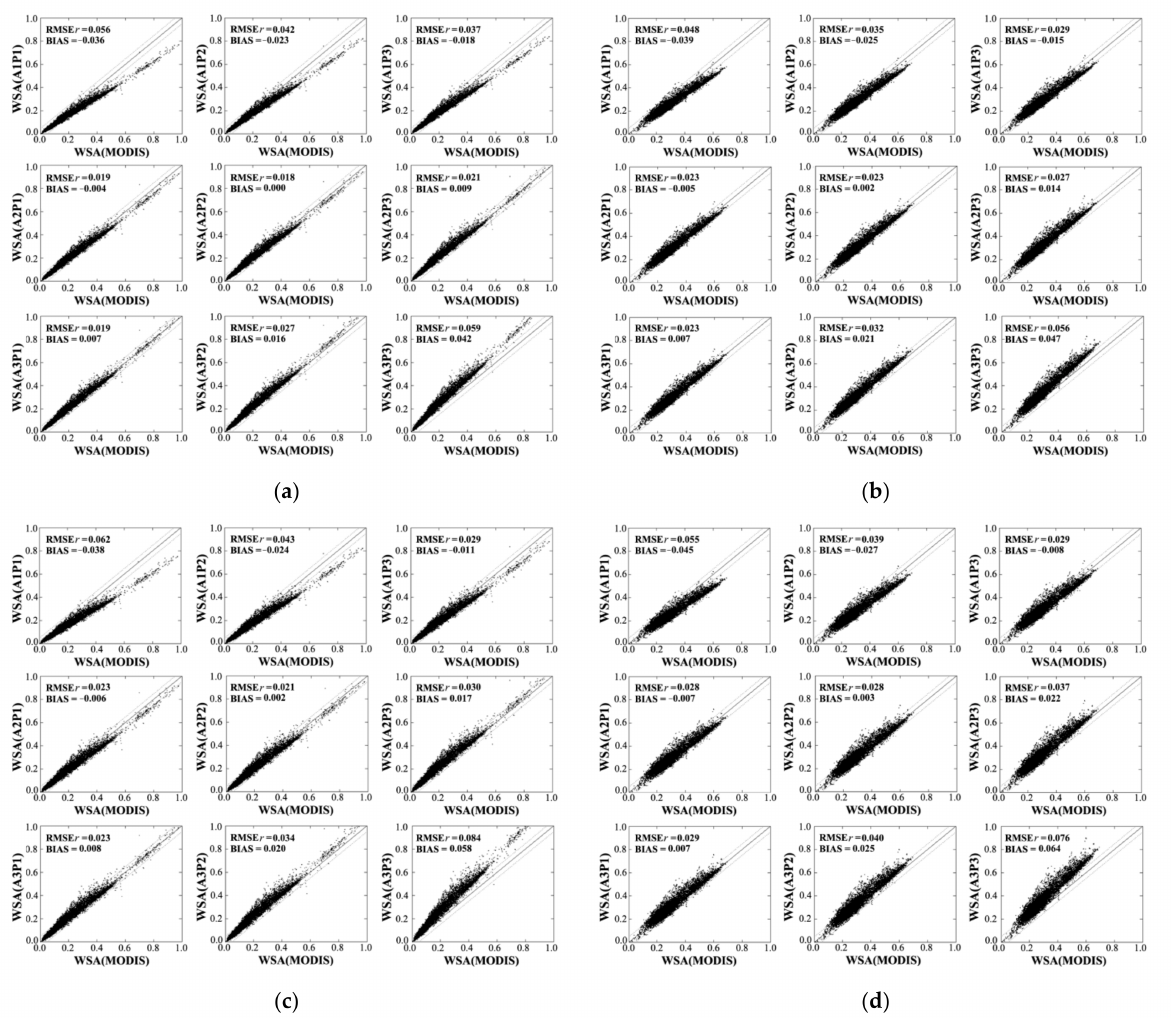
Figure 7. Comparison of MODIS WSA product with WSA retrieved from different BRDF archetypes and sufficient ( a ) and insufficient ( b ) multi-angular reflectance in the red ( a , c ) and NIR ( b , d ) bands. A1P1 to A3P3 refer to the class number of BRDF archetypes. The insufficient multi-angular reflectance refers to the reflectance in the